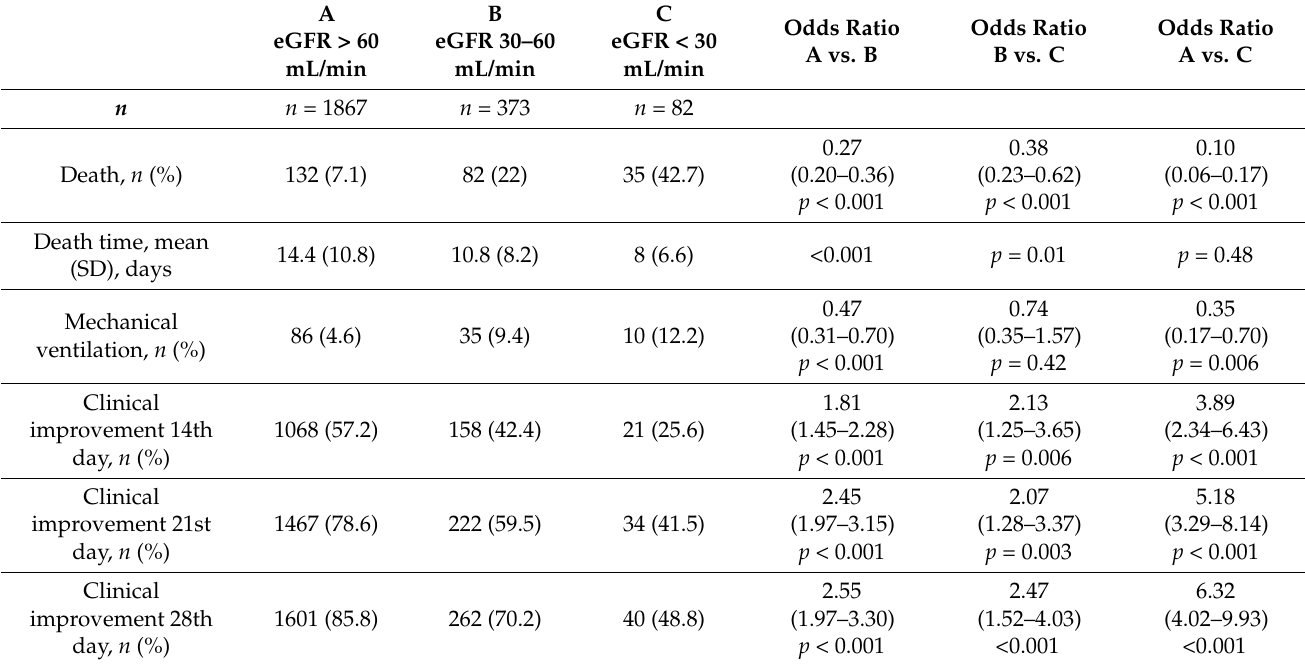
Table 4. Outcome according to baseline kidney